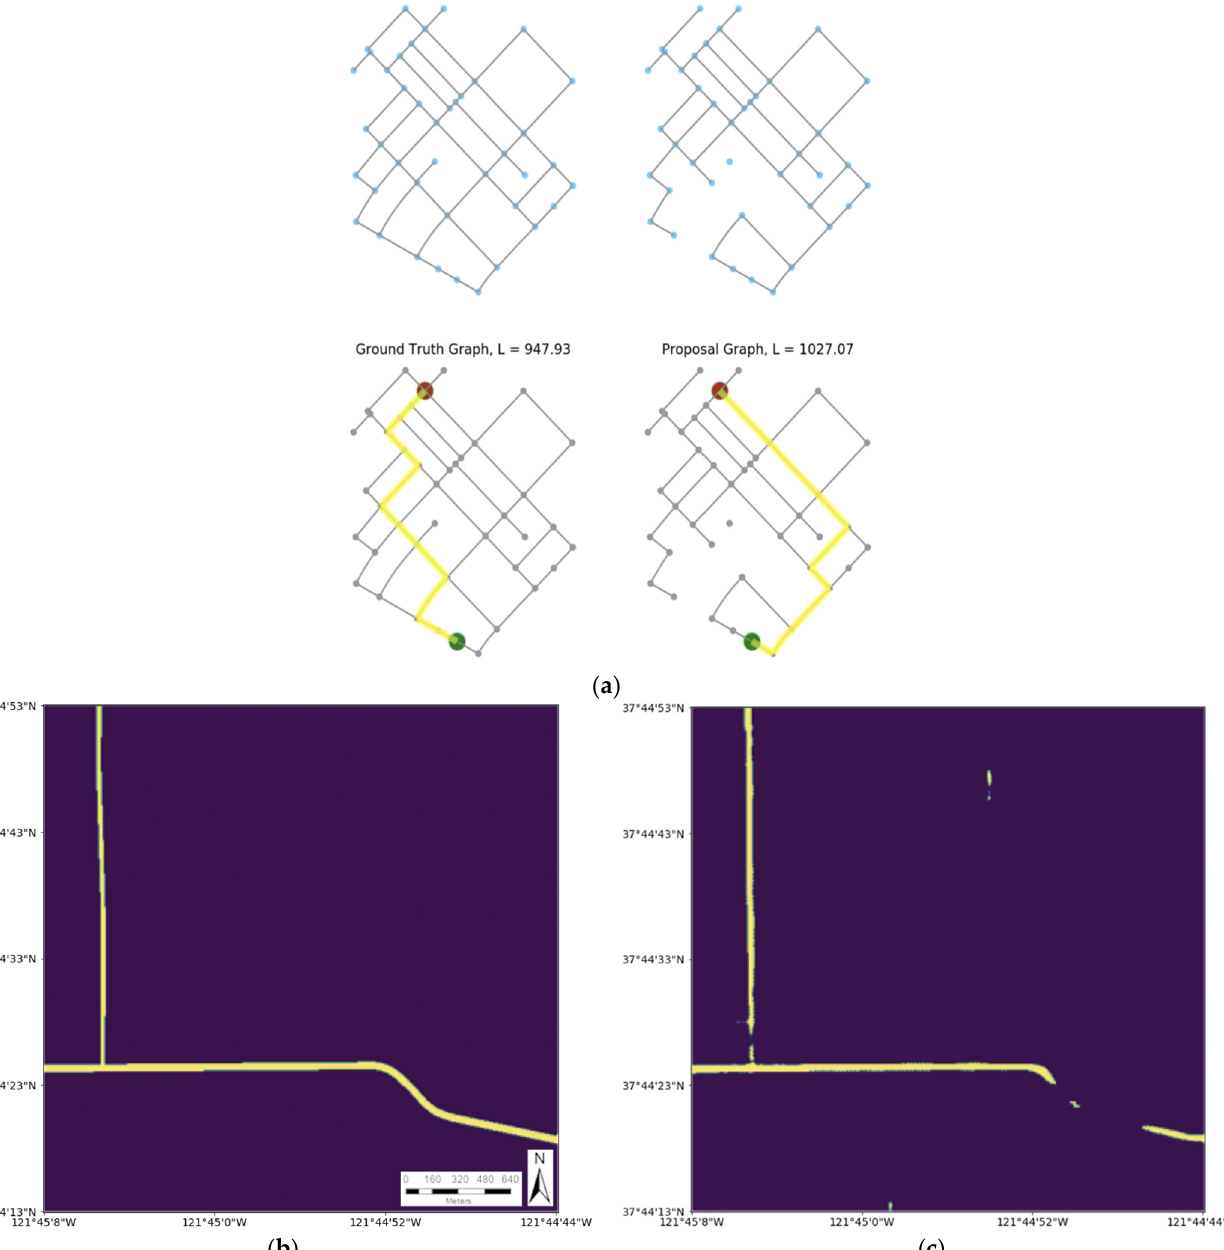
Figure 4. ( a ) The average path length score (APLS) code takes a ground truth label and prediction from the segmentation network and converts those images to graph representations [47]. In this example, the proposal graph resulting from the predicted image is missing connective edges (roads). This results in a longer optimal path between the two points illustrated in the lower two images, and a lower APLS score. ( b ) Ground truth image chip. ( c ) APLS is heavily penalized (0.06) due to missing connective regions, and the addition of a false positive section in the upper middle of the image chip. Intersection over union (IoU) scores relatively high (0.66), despite this.